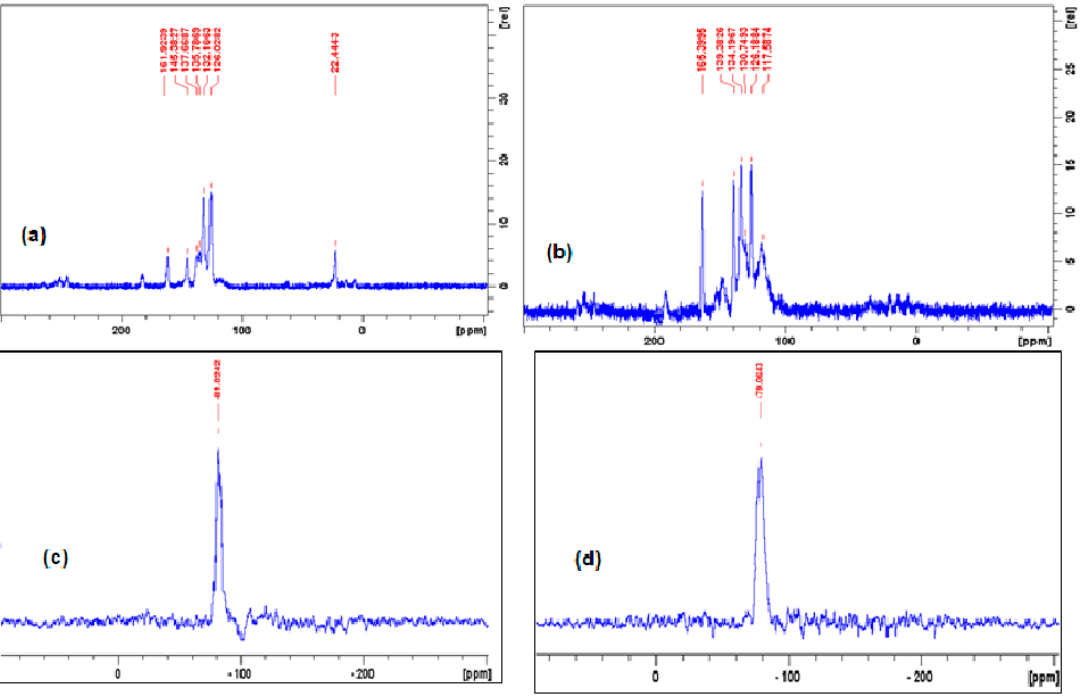
Figure 6. CP-MAS 13 C solid-state NMR spectrum of ( a ) COF-S7 and ( b ) COF-S12, and CP-MAS 29 Si solid-state spectrum of ( c ) COF-S7 and ( d ) COF-S12.